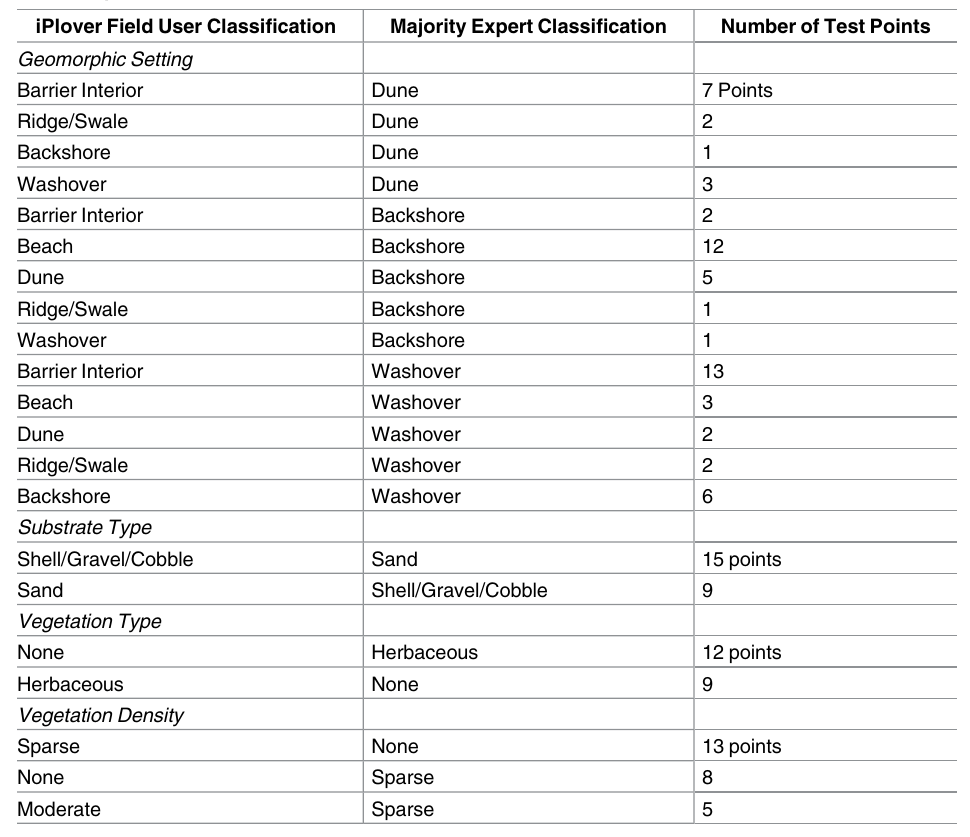
Table 3. Common differences a in how habitat conditions (Geomorphic Setting, Substrate Type, Veg- etation Type, and Vegetation Density) were described according to iPlover field users and subject- matter experts.